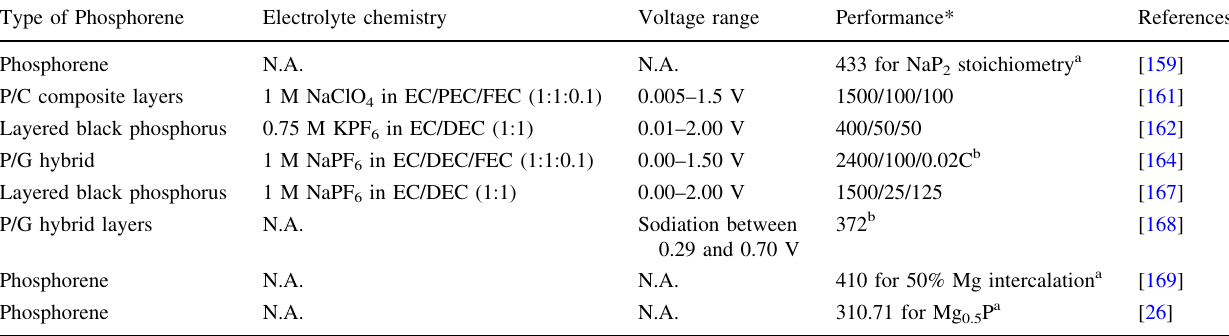
Table 6 Performance of BP/phosphorene anode, in various non-Li metal ion rechargeable battery